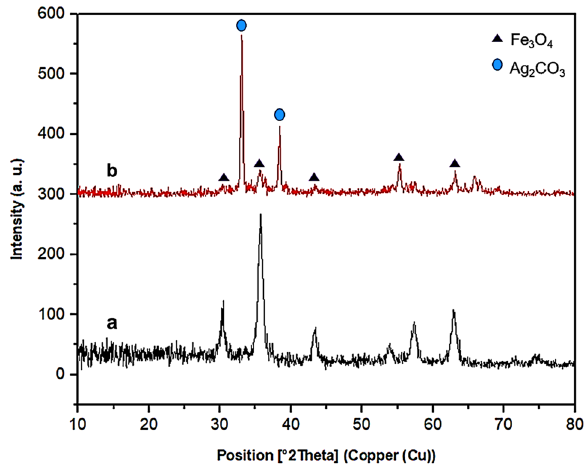
Figure 3. Wide angle-PXRD pattern of the ( a ) Fe 3 O 4 and ( b ) MS/Ag 2 CO 3 nanomaterials.